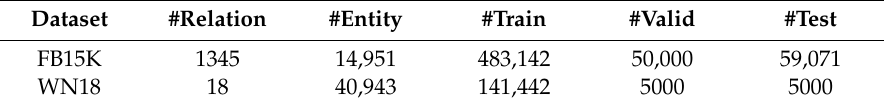
Table 1. The statistics of number of triples in our experiment.